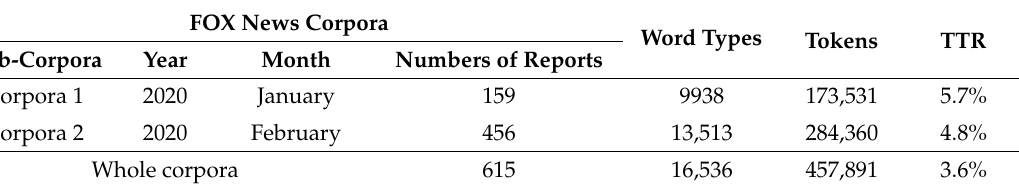
Table 1. Quantitative characteristics of the target corpora.